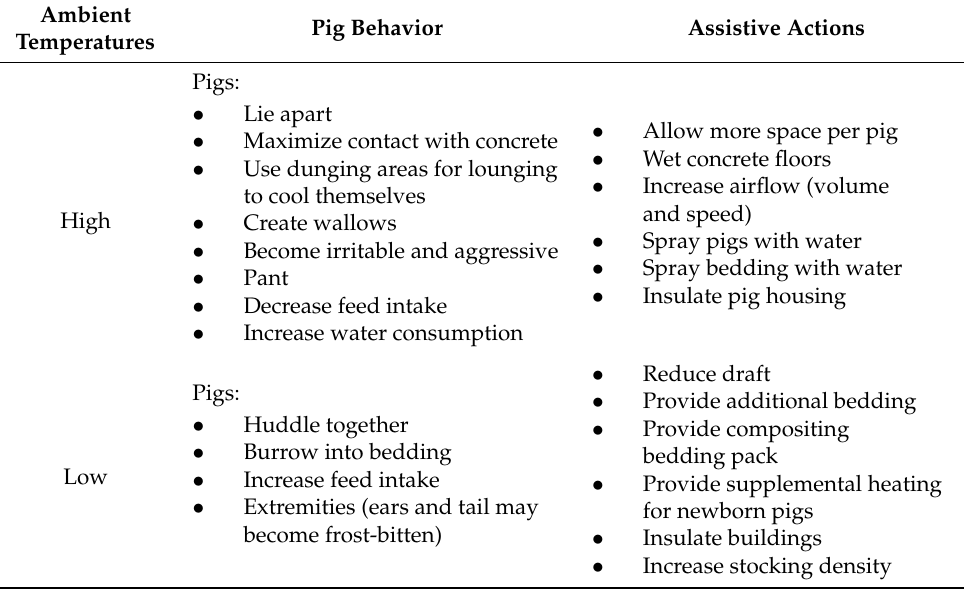
Table 4. Pig behavior and indicative assistive actions under the different environmental